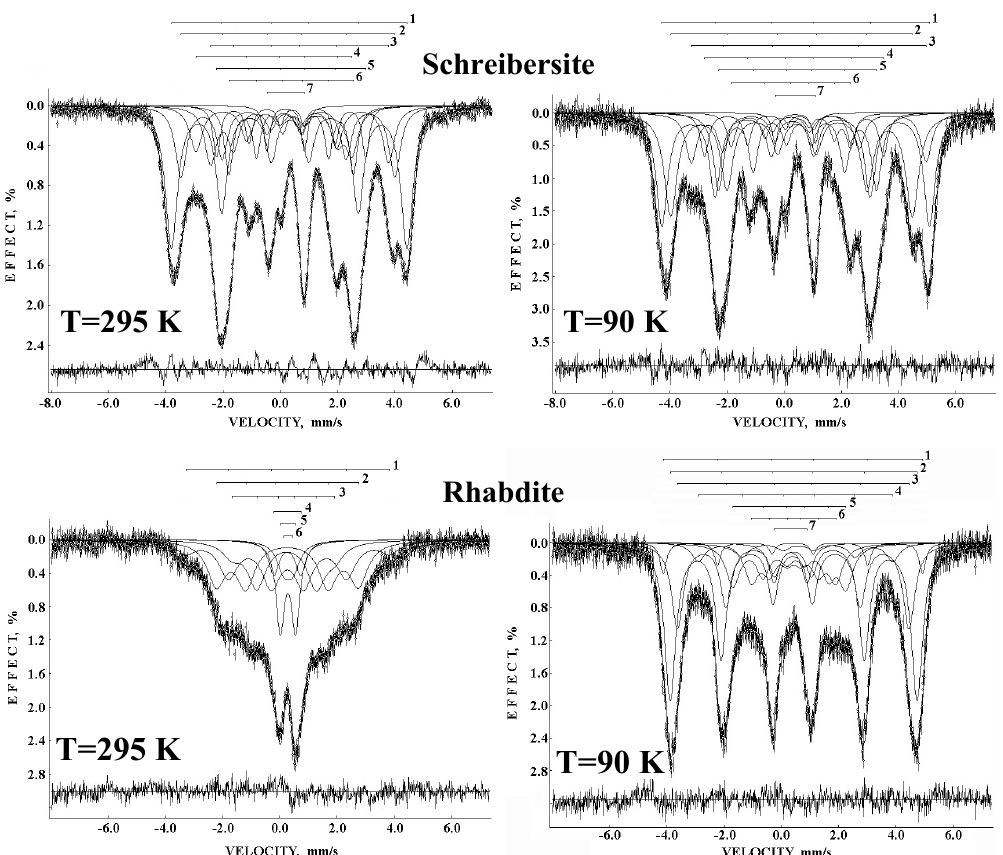
Figure 38. Mössbauer spectra of schreibersite and rhabdite microcrystals extracted from Sikhote-Alin IIAB iron meteorite measured with a high velocity resolution at 295 K and 90 K. Indicated spectral components are the results of the best fits. The differential spectra are shown on the bottom. Adapted from [96].